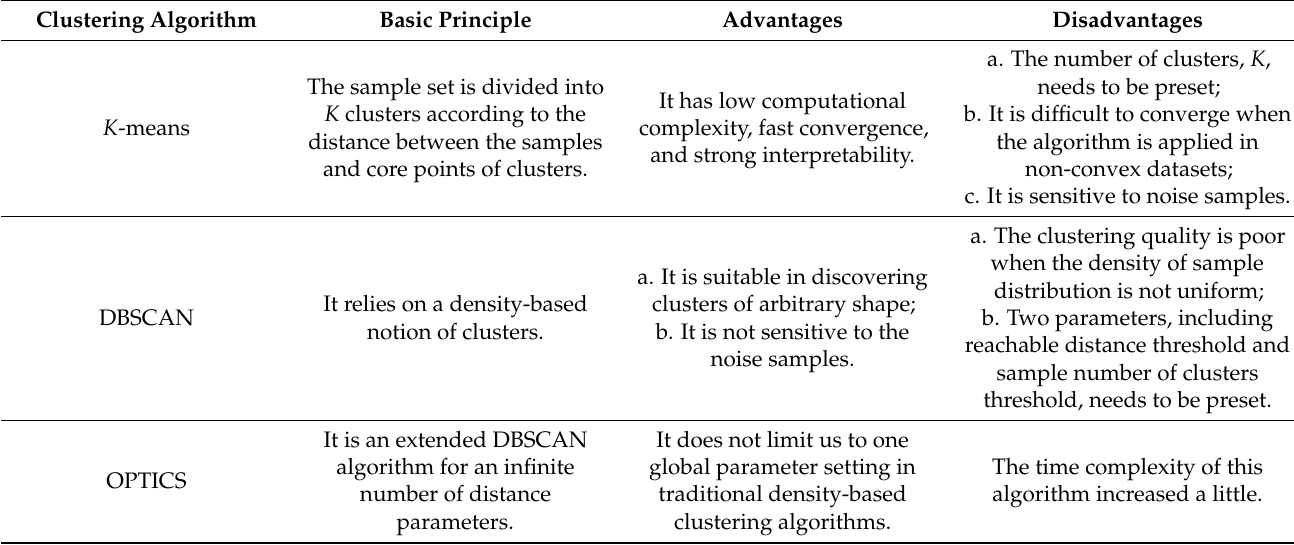
Table 3. Comparison results among different clustering